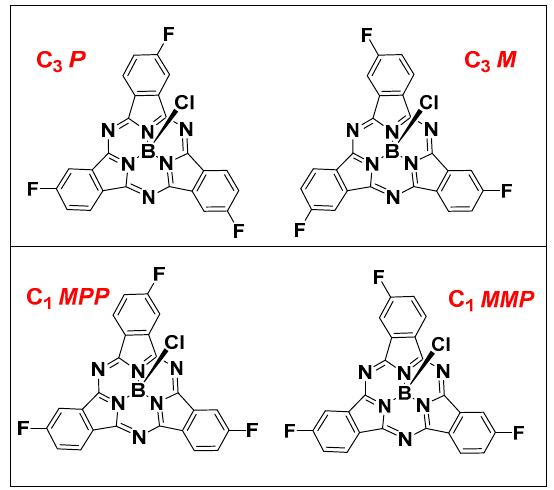
Figure 1. C 3 constitutional isomers ( upper ) and C 1 constitutional isomers ( lower ) of F 3 SPcs.